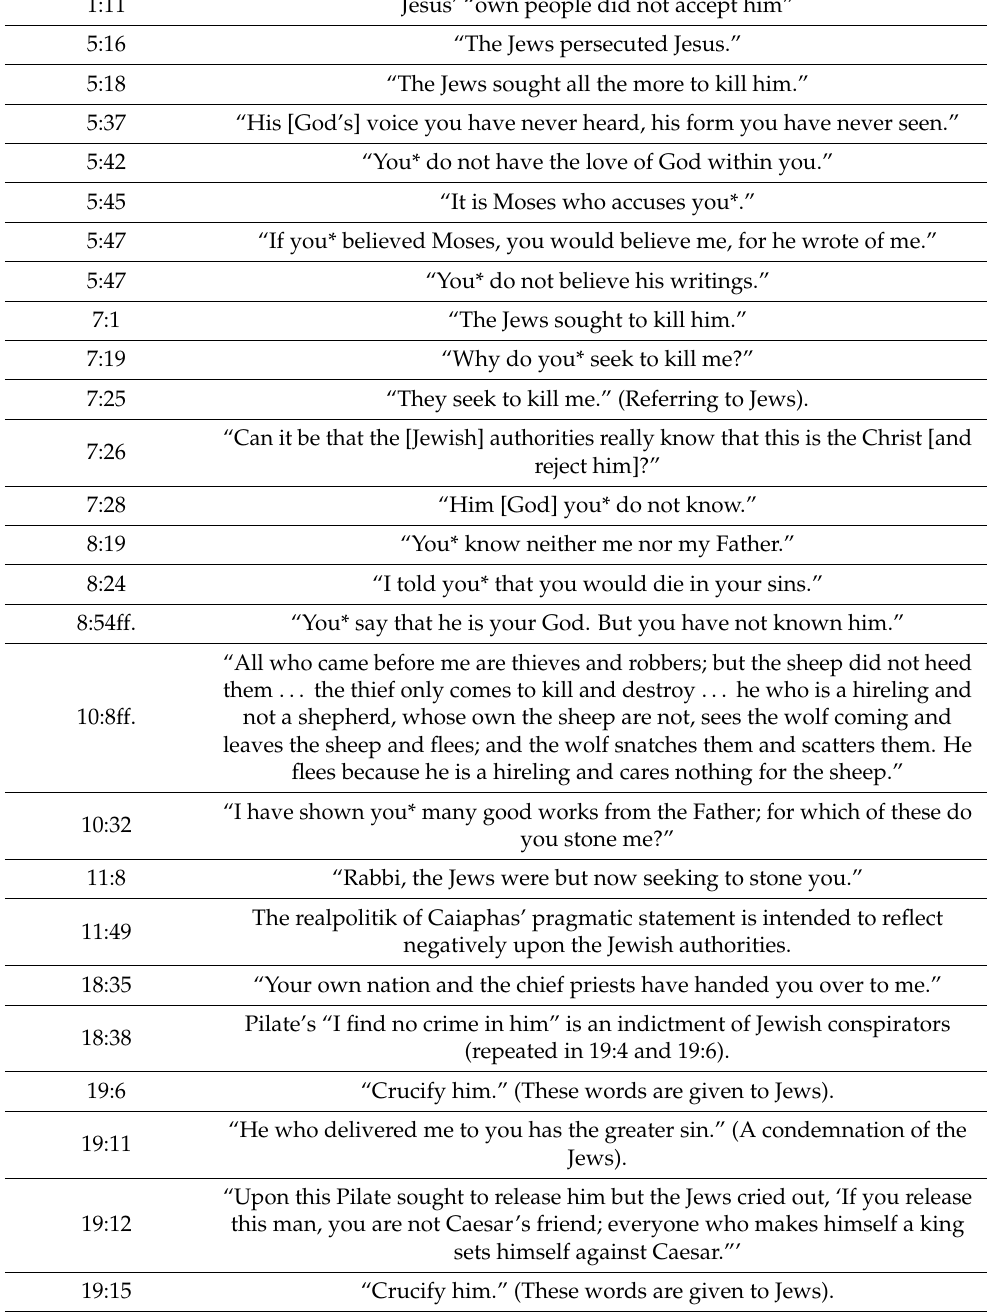
Table 1. Some of the Negative Portrayals of “the Jews” in the Gospel of John. (An * denotes that